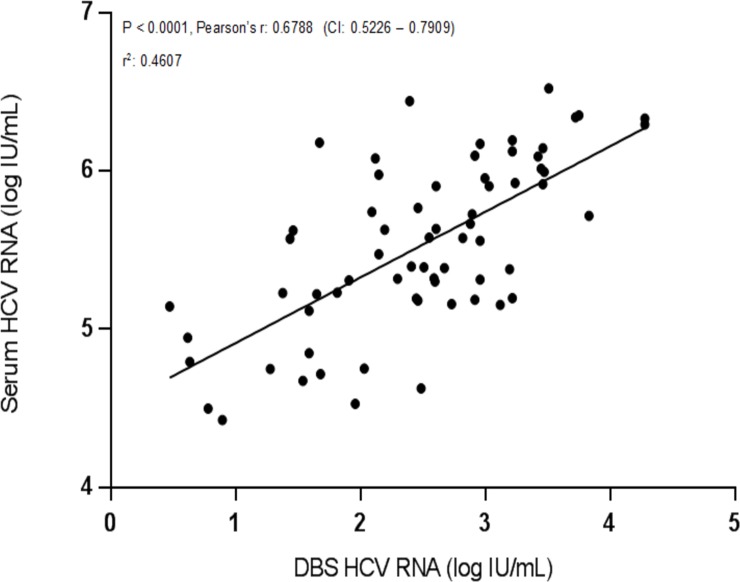
Linear regression showing correlation between HCV-RNA Concentrations in plasma and DBS samples.